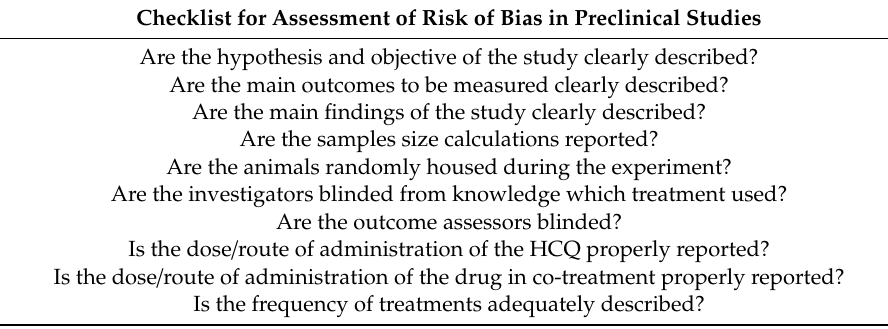
Table 3. Checklist for assessment of the risk of bias in preclinical studies [171,172]. Checklist for Assessment of Risk of Bias in Preclinical Studies Are the hypothesis and objective of the study clearly described?